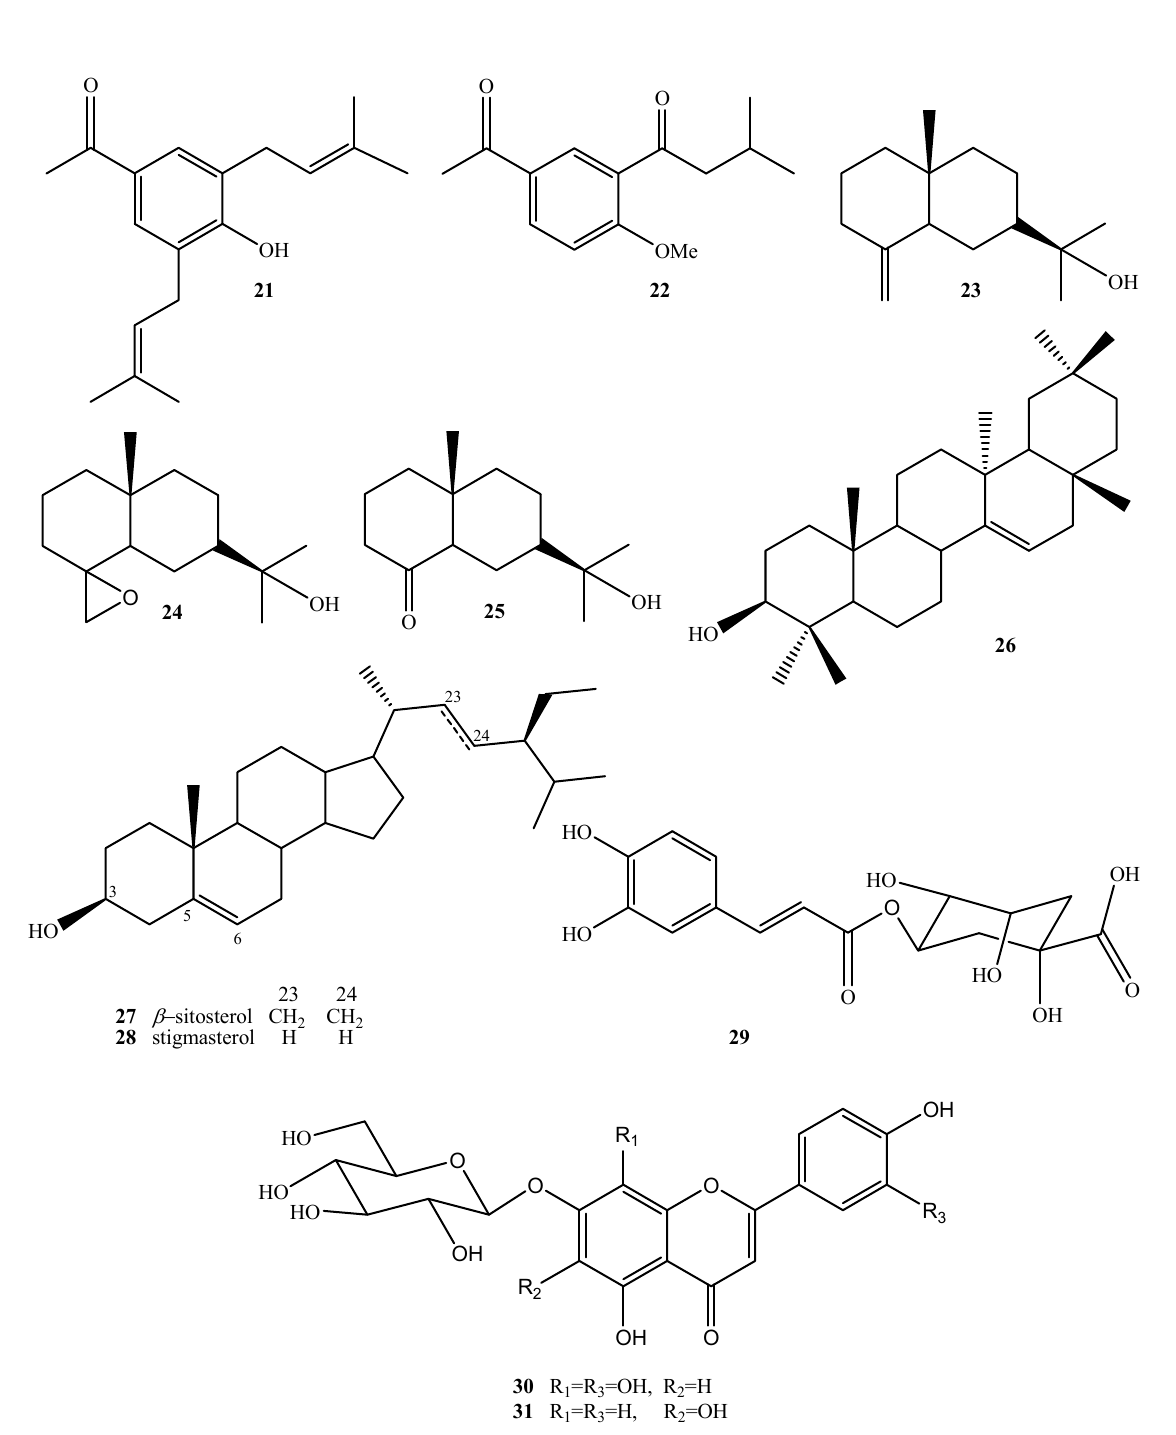
Figure 4. Chemical structure of terpenes and phenolic compounds isolated from A. pichinchensis .